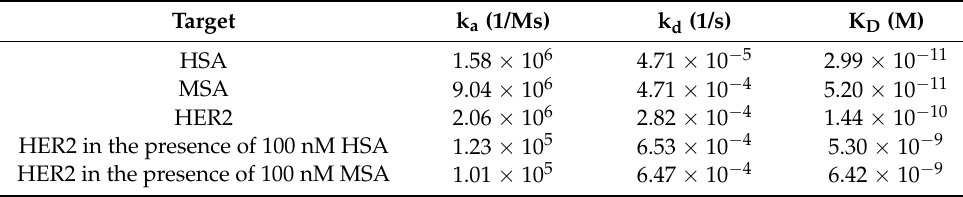
Table 1. Kinetic parameters of PEP40233 interacting with HER2, HSA and MSA.